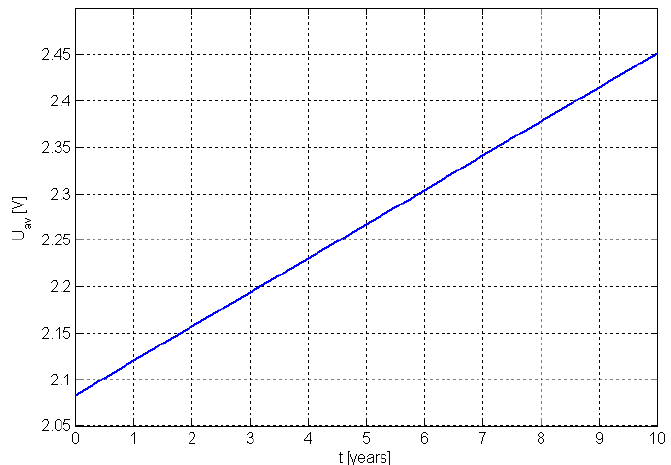
Figure 8. Average voltage growth in the electrolyzer as a function of years of operation—own study based on [44].